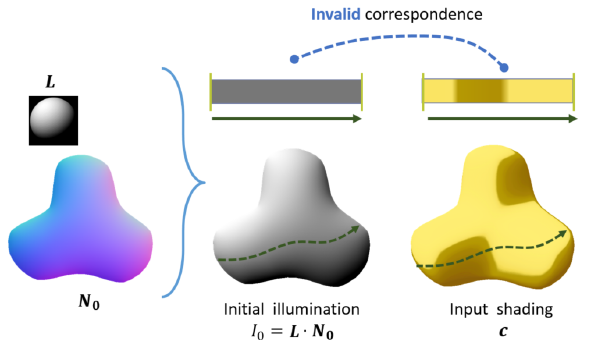
Fig. 5 Invalid correspondence between the initial illumination I 0 and the input shading c .